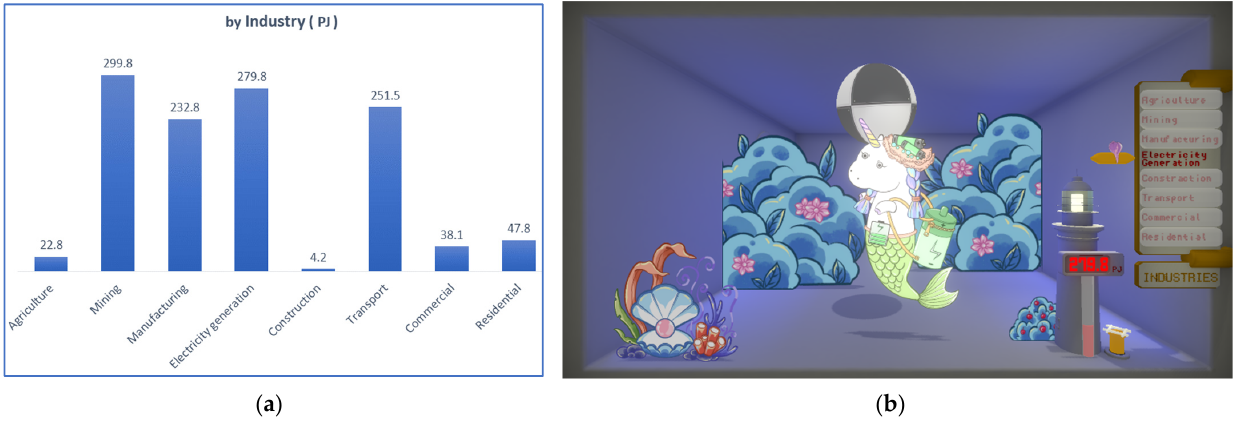
Figure 4. A bar chart and the interactive prototype. Both are based on the same data. ( a ) The bar chart; ( b ) the visual data storytelling prototype.